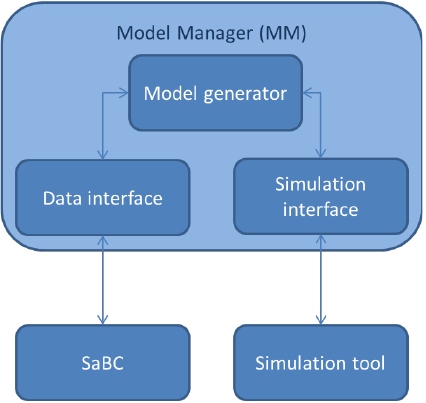
Figure 3. Model Manager module